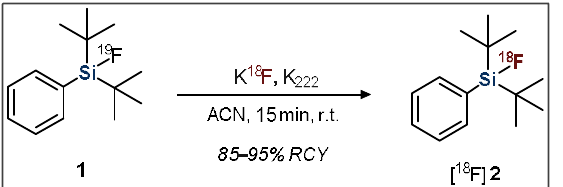
Figure 2. General scheme showing the radiofluorination of a dialkylfluorosilane SiFA compound.